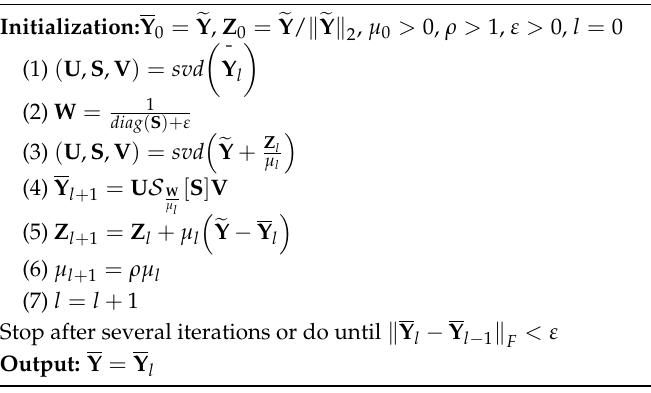
Algorithm 1. Echo denoising via the inexact ALM